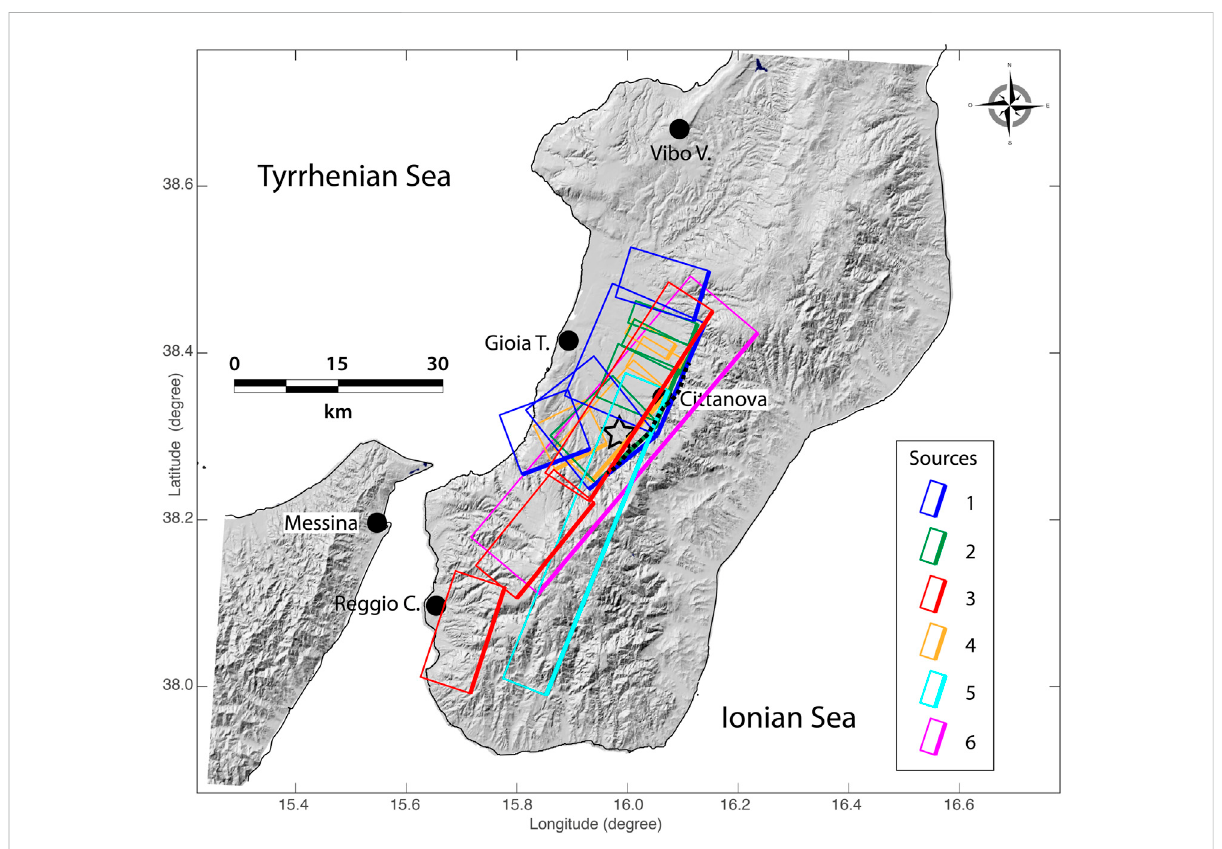
FIGURE 3 Location of the NW-verging competing potentian sources of the 1783 earthquake (epicenter shown as a black star): 1, Jacques; 2, Galli_ Peronace; 3, Valentini; 4,GAlli_Bosi; 5, Minelli; 6, Boxer_NW. A thicker line indicates the top edge of the source. The black dashed line marks the pattern of the surface ruptures observed in the fi eld after the